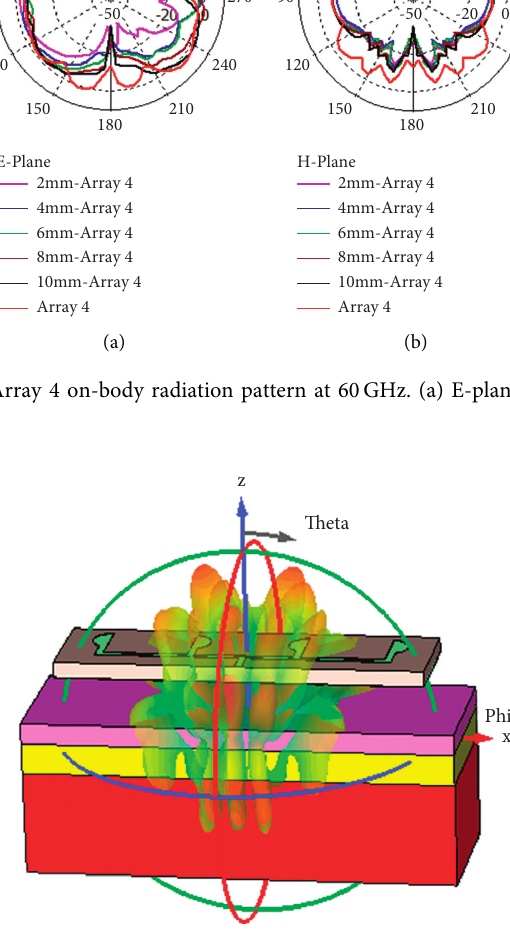
Figure 32: Array 4 on-body 3D radiation pattern at